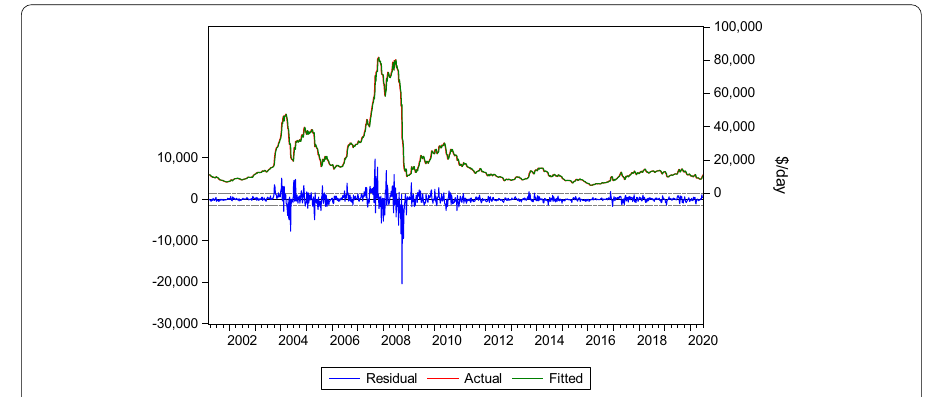
Fig. 10 One-year time-charter 75.000 dwt. Source: Elaboration by the authors